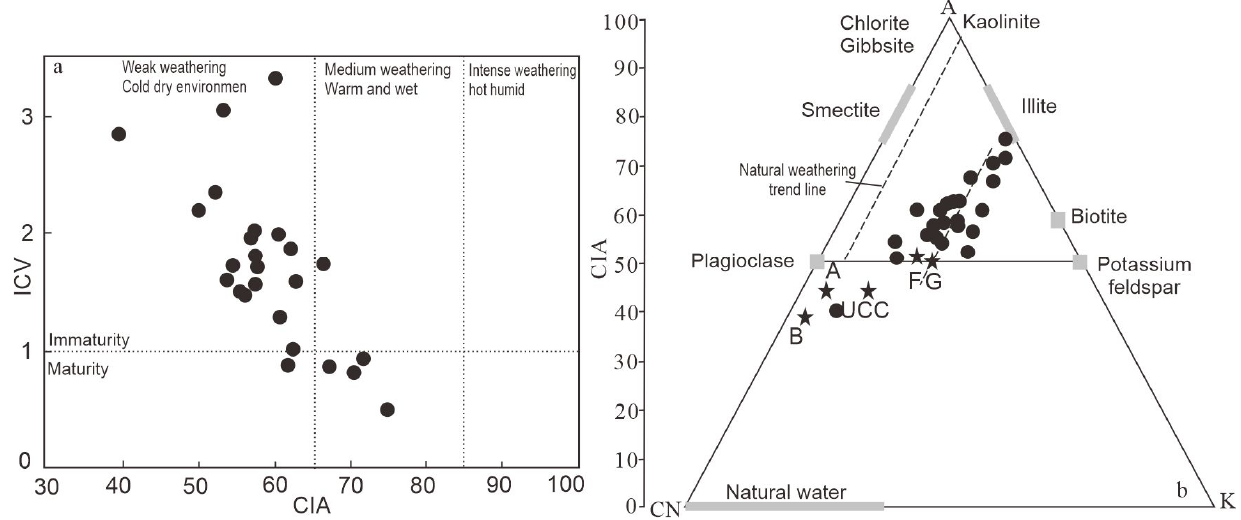
Figure 7. Palaeoclimate discrimination diagram of the Yanyuan Basin. The CIA–ICV diagram ( a ) and A–CN–K diagram ( b ) of the study area base map from [14,16]. Stars: A—andesite; B—basalt; F—felsic igneous rock; G—granite; UCC—upper continental crust.